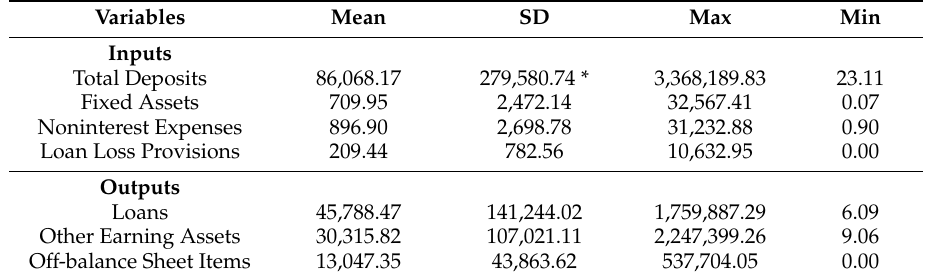
Table 2. Descriptive statistics of the inputs and outputs of banks in the Asia-Pacific region